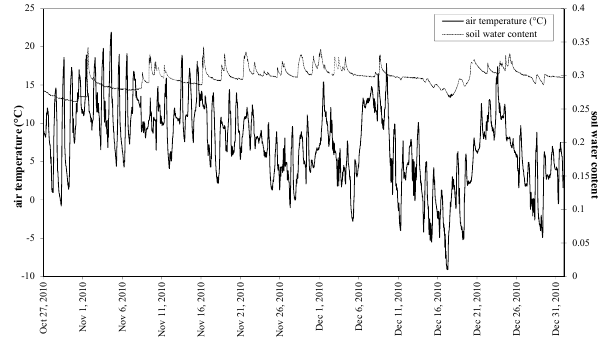
Fig. 10. Observed soil water content at 5cm depth and air tem- Figure 10. Observed soil water content at 5 cm depth and air temperature at 2 m above the 3 perature at 2m above the ground as functions of time in a limited ground as functions of time in a limited interval of the study period. 4 interval of the study